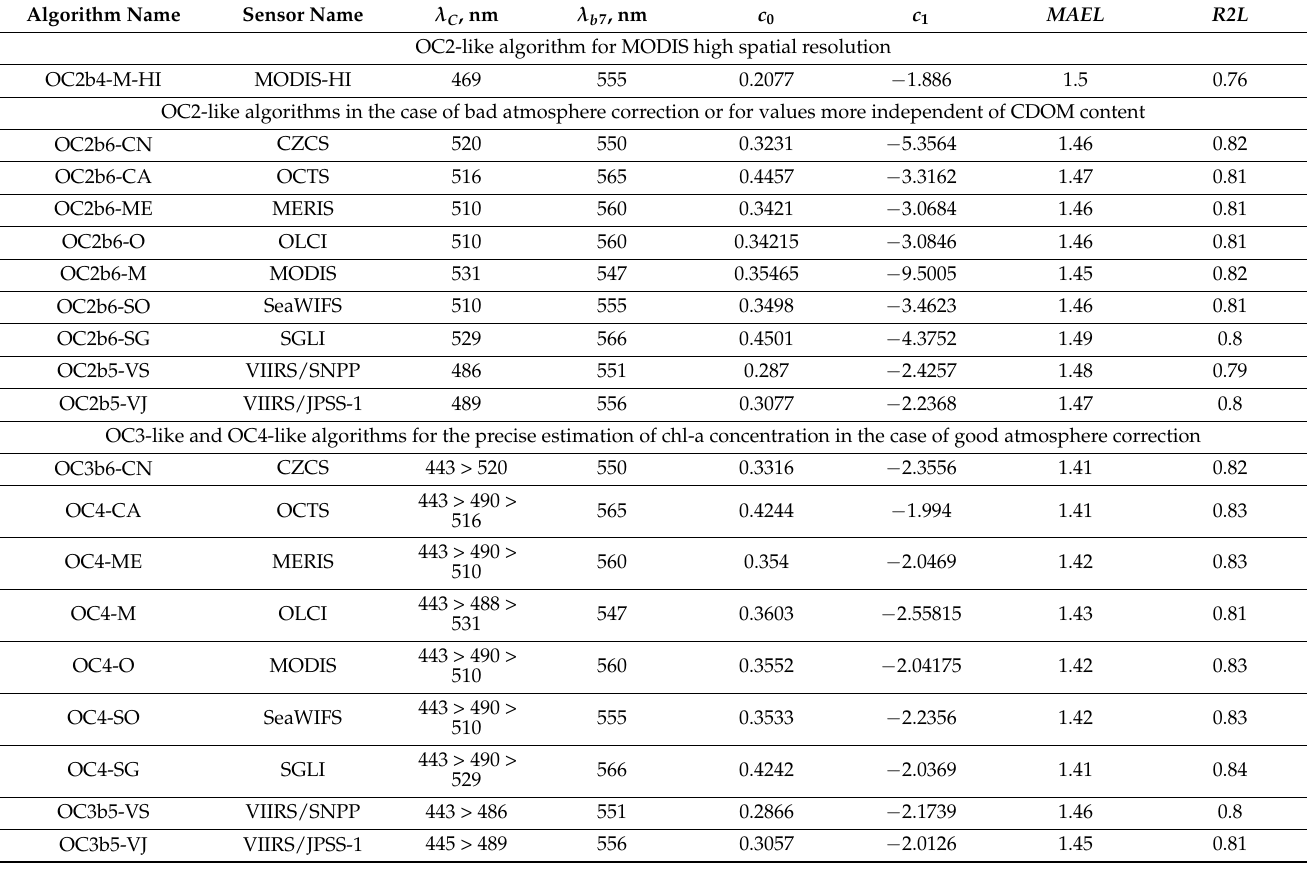
Table 10. Set of satellite regional bio-optical algorithms for the estimation of chl-a concentration in mg/m 3 for the range 0.17 to 9.29 mg/m 3 and related